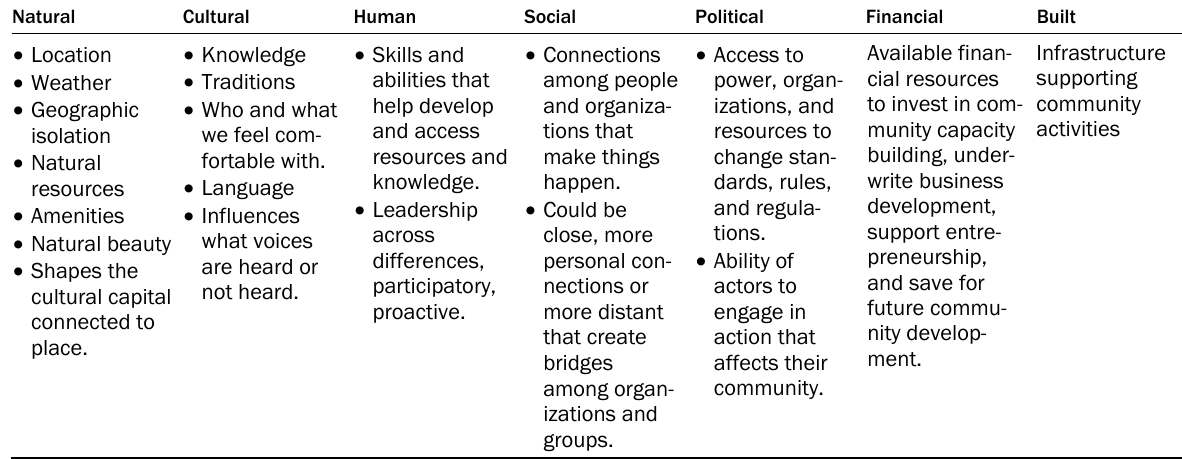
Table 1. Community Capitals Framework